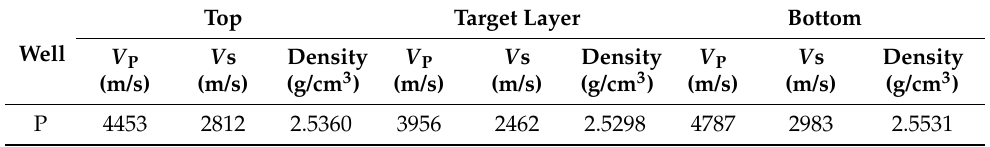
Table 1. Seismic properties, corresponding to the sandstone model of the Xujiahe